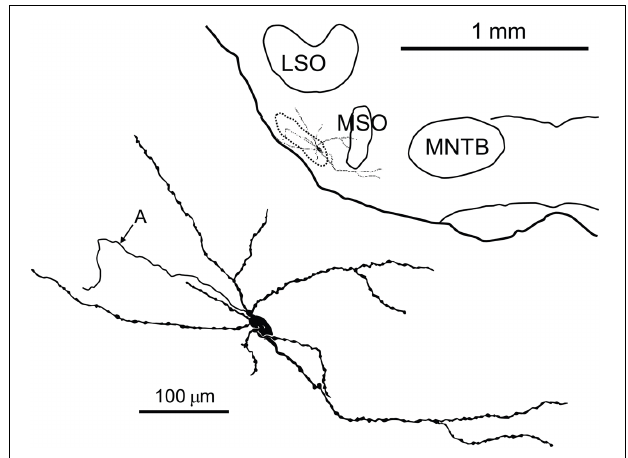
FIGURE 5 | Camera lucida drawing of a labeled neuron in the pvLNTB with an extensive dendritic tree. Inset shows the location of the labeled cell on a coronal brainstem section. A, axon; LSO, lateral superior olive; MNTB, medial nucleus of the TB; MSO, medial superior